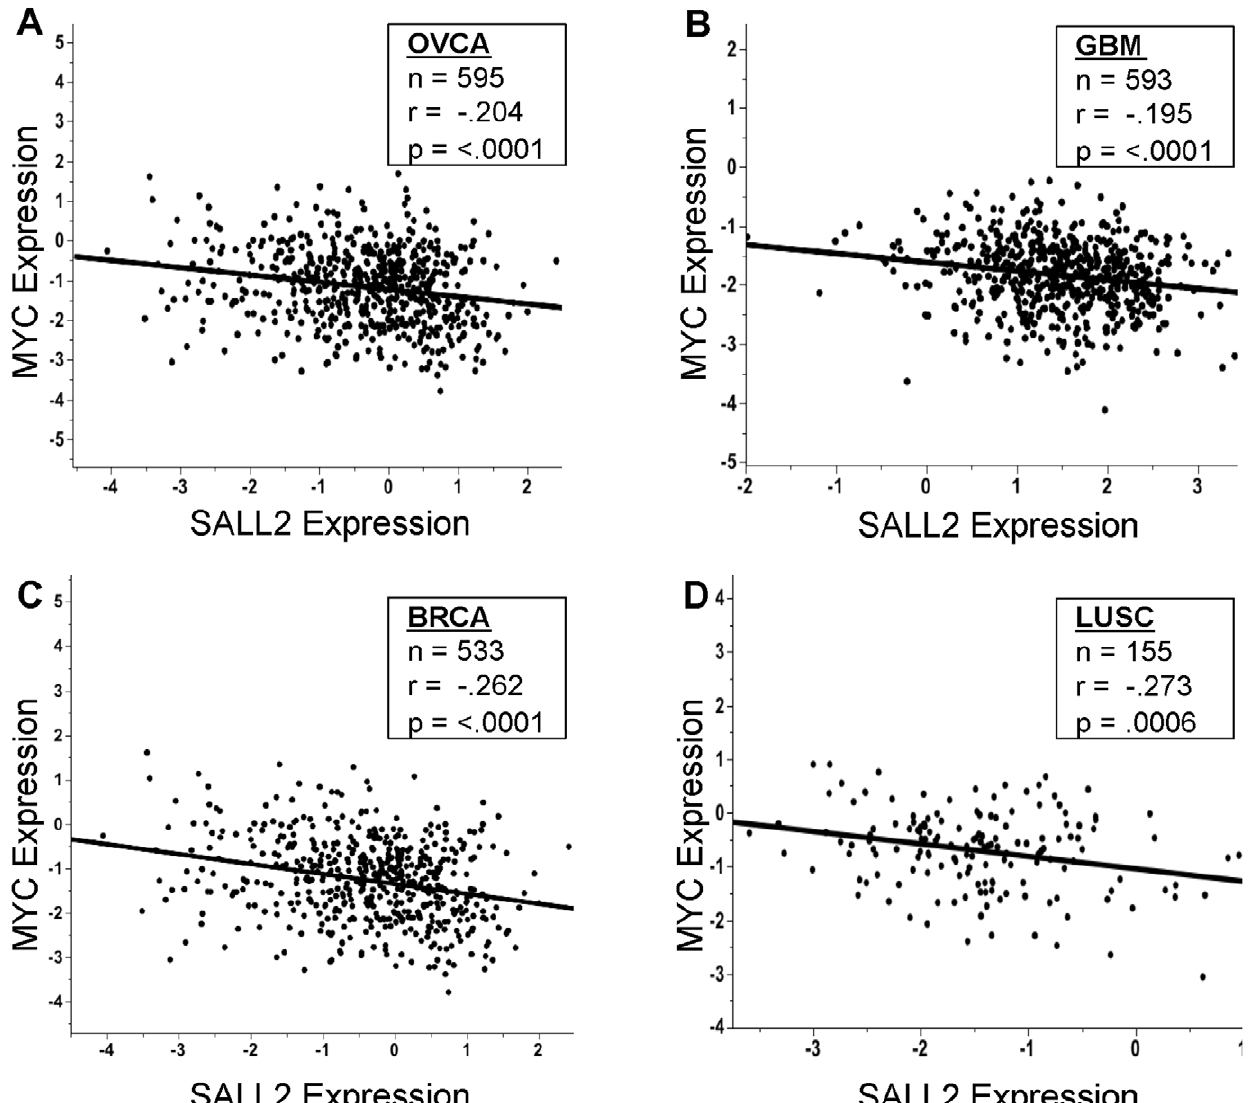
Figure 4. SALL2 by c-MYC expression scatterplots for cancer types in The Cancer Genome Atlas. (A) OVCA - ovarian serous cystadenocarcinoma. (B) GBM – glioblastoma multiforme. (C ) BRCA – breast invasive carcinoma. (D) LUSC – lung squamous cell carcinoma. n=number of samples; r=Pearson correlation coefficient; p=p-value of the correlation. The lines shown are those of best fit.